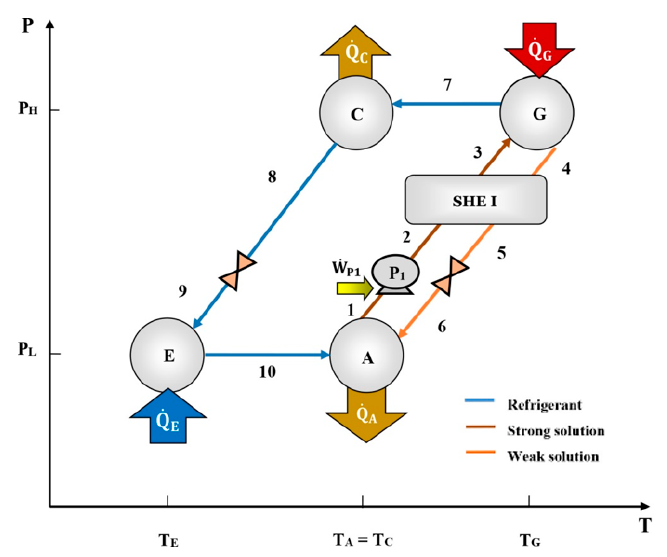
Figure 1. Pressure–Temperature diagram for a single-effect absorption cooling system.